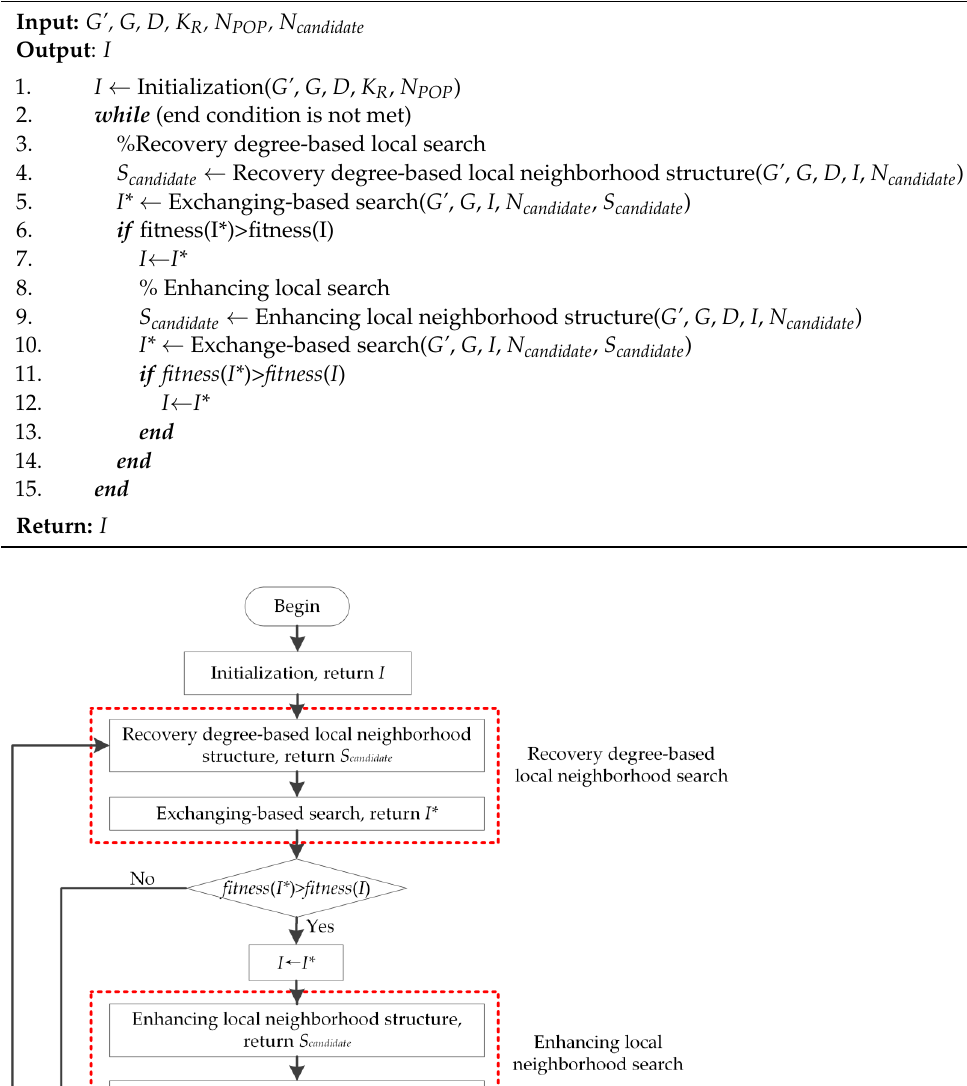
Algorithm 1. Enhanced variable neighborhood search (EVNS)